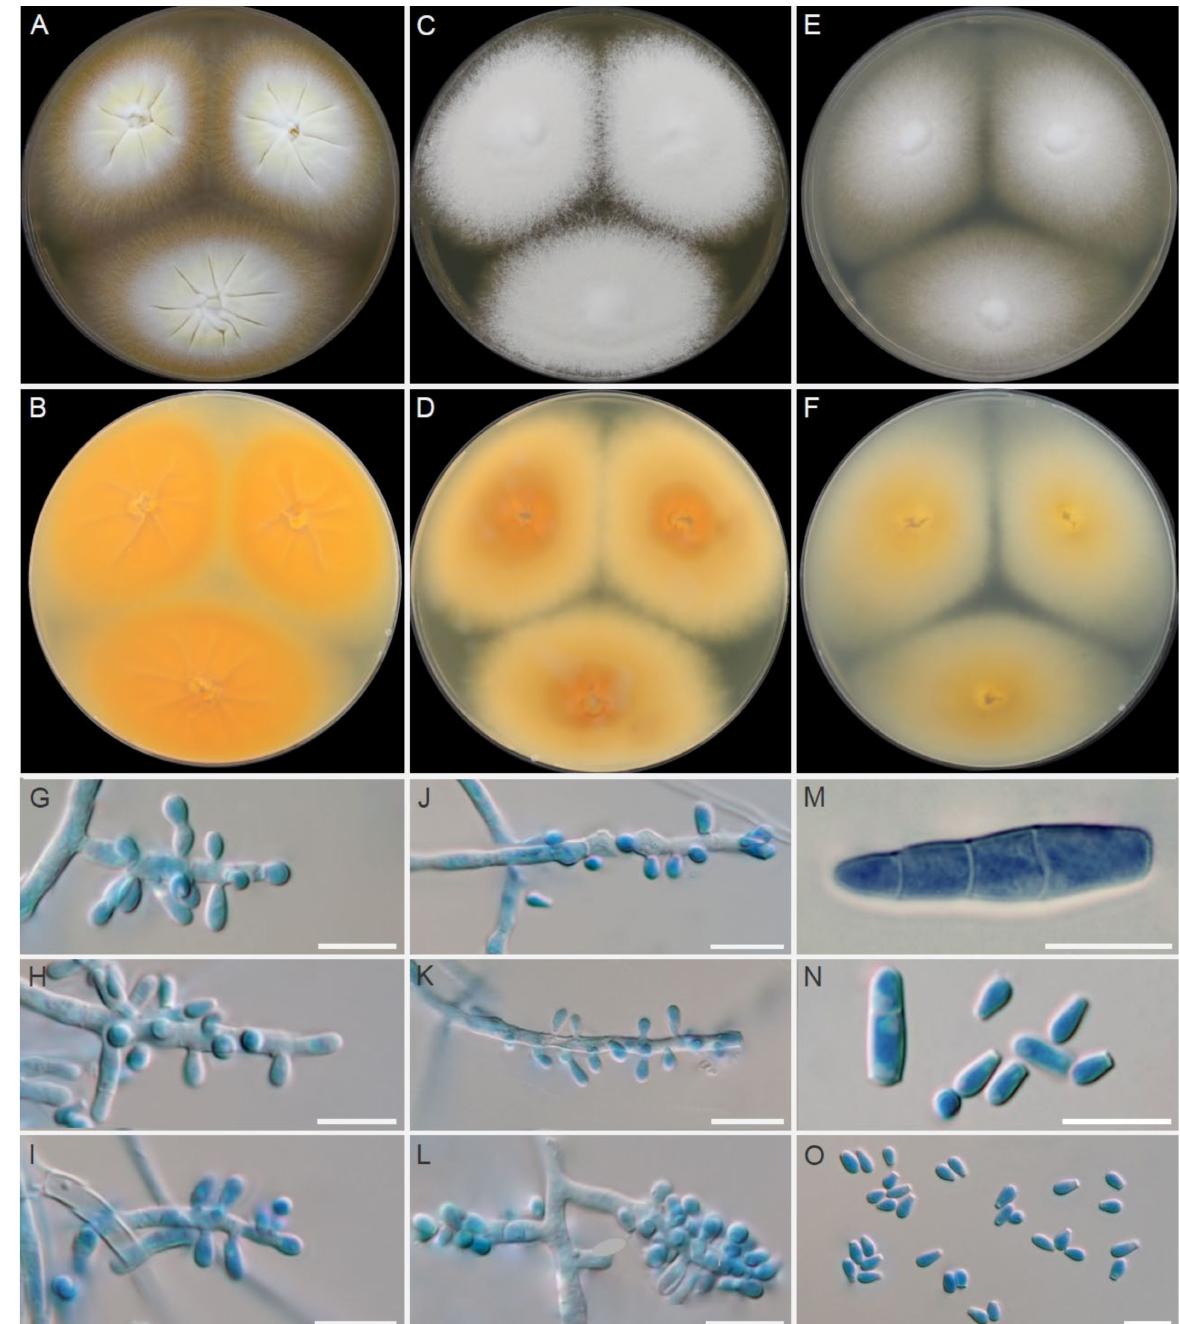
Figure 4. Macromorphology and micromorphology of Trichophyton erinacei . Colonies after two weeks of cultivation at 25 ◦ C on Sabouraud’s dextrose agar ( A , B ), potato dextrose agar ( C , D ) and malt extract agar ( E , F ). Conidiophores bearing microconidia ( G – L ); macroconidia ( M ); free microconidia and two-celled macroconidia ( N ); microconidia ( O ). Scale bars = 10 µ